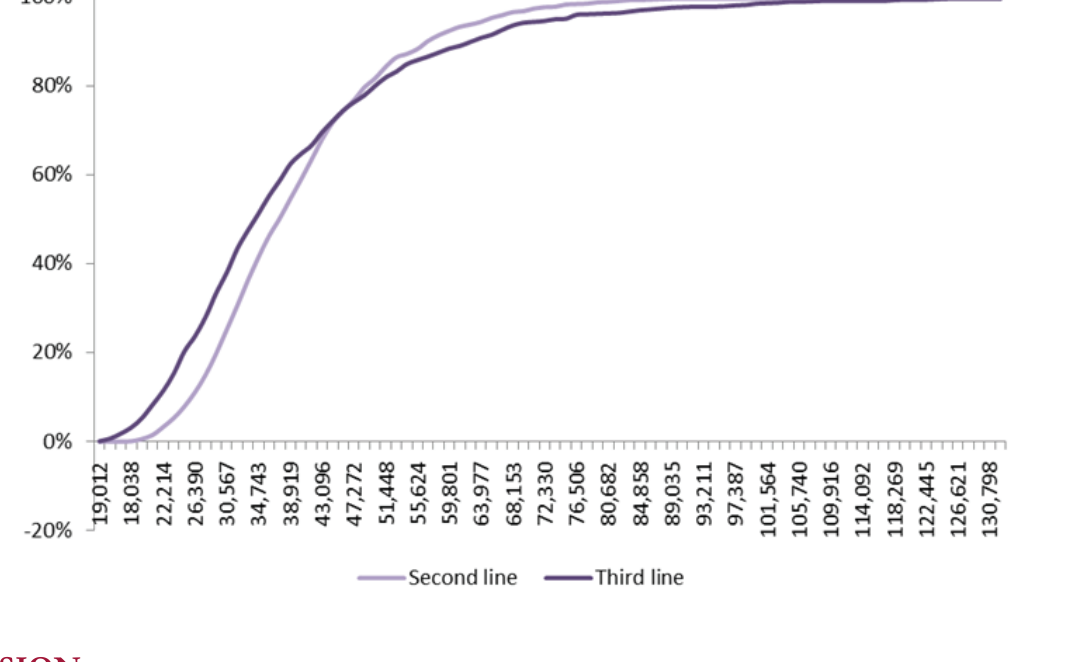
Figure 5. Cost-effectiveness Acceptability Curve for